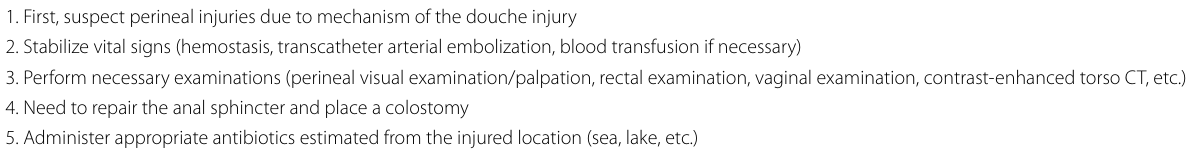
Table 2 The treatment strategy for the douche injury related to a PWC 1. First, suspect perineal injuries due to mechanism of the douche injury 2. Stabilize vital signs (hemostasis, transcatheter arterial embolization, blood transfusion if